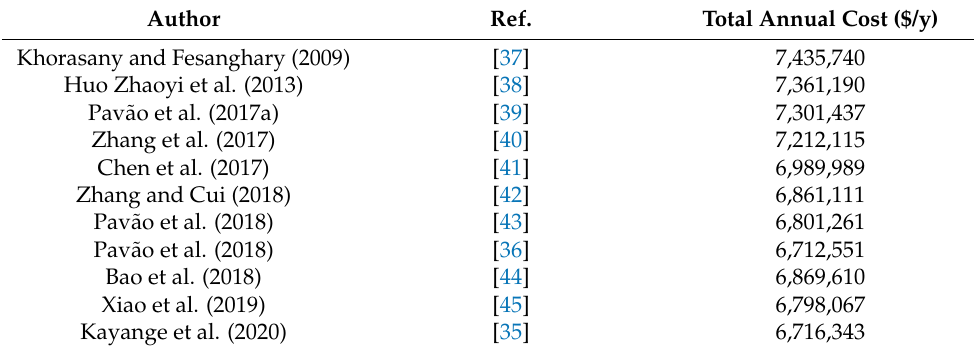
Table 4. Various study results on the optimal total annual cost of HEN for case study